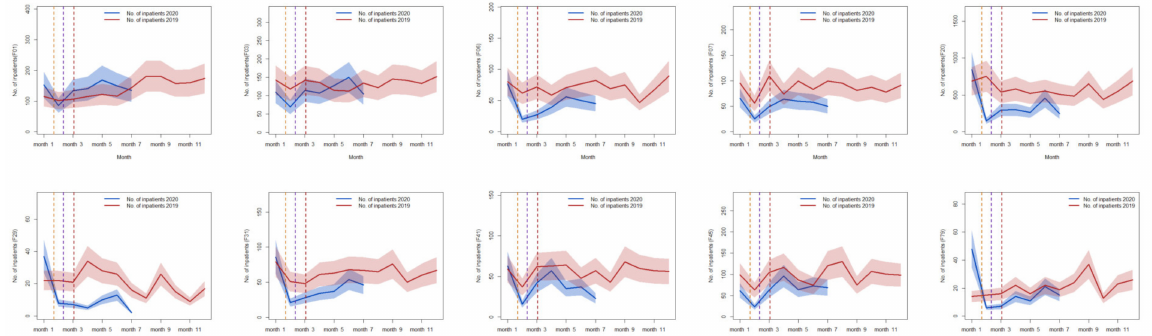
Figure 6. Utilization of ten mental illness services from January 2019 to July 2020. Legend: The ten diseases for mental health service utilization from January 2019 to July 2020. Note: F01, vas- cular dementia; F03, unspecified dementia; F06, other mental disorders due to brain damage and dysfunction and to physical disease; F07, personality and behavioral disorders due to brain disease, damage and dysfunction; F20, schizophrenia; F29, unspecified nonorganic psychosis; F31, bipolar affective disorder; F41, other anxiety disorders; F45, somatoform disorders; F79, unspecified mental retardation. The red line is the number of inpatients in 2019. The blue line is the number of inpatients from January to July 2020. The shades of blue and red represent the 95% CI of the regression line. Figure 7 shows the trends in the utilization of psychiatric inpatient care from January to July 2020. The observed number of inpatient patients was significantly lower than the predicted number in 2020, and it was about 51.07% lower than the predicted number. During the COVID-19 period, average monthly visits dropped by approximately 1068 ( p < 0.001) (Table 2).